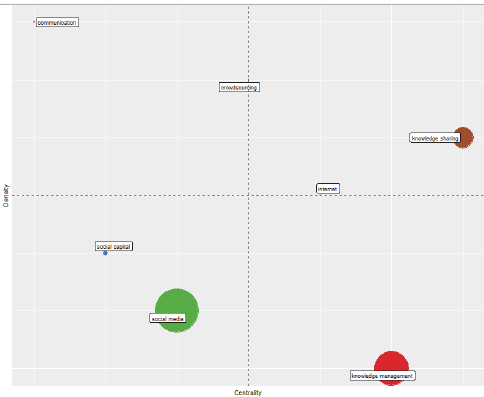
Fig. 6. Thematic map Fig. 7. Historical direct citation